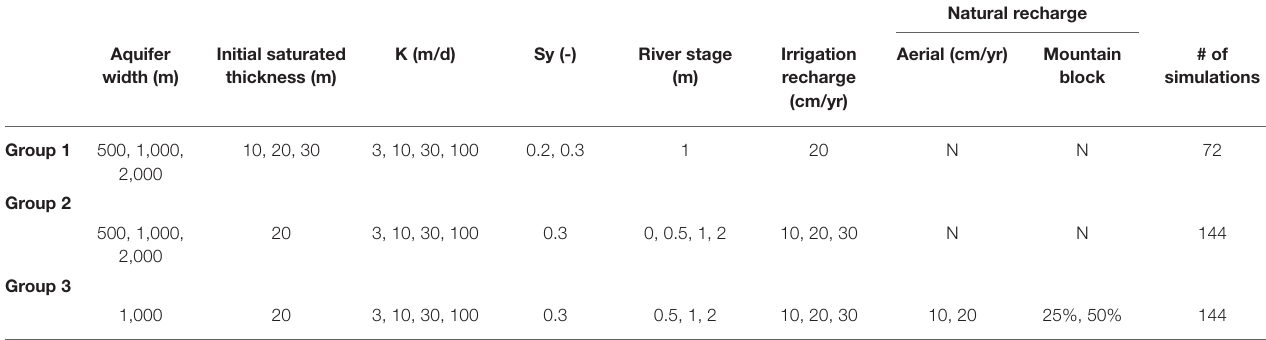
TABLE 1 | Parameter and boundary condition settings for the three experiment